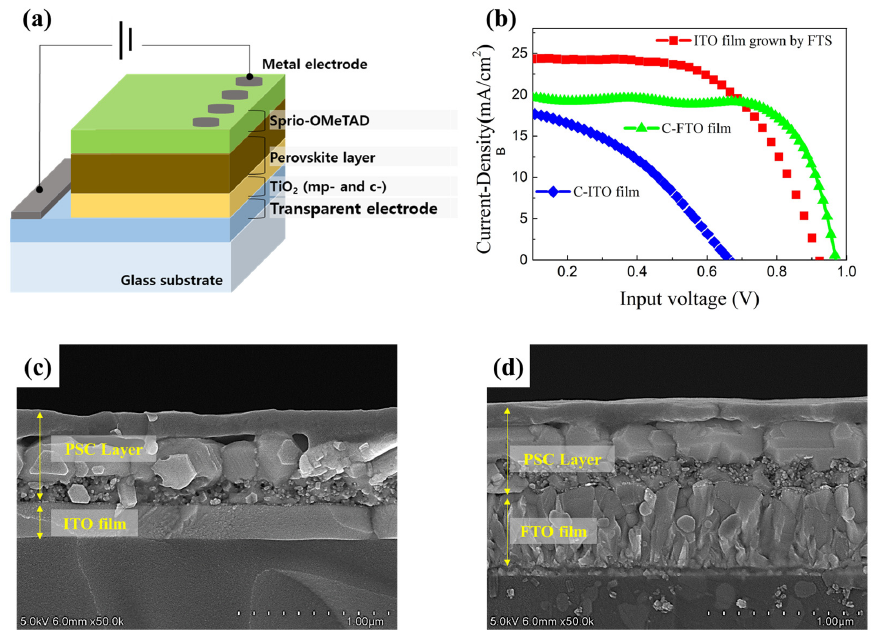
Figure 6. ( a ) structure of a perovskite solar cell consisting of a transparent conductive oxide (TCO), TiO2 layer as electron-transport layer (ETL), light-absorbing perovskite materials, spiro-OMeTAD as hole-transport layer (HTL), and Au metal electrode, ( b ) current density of PSCs with various TCOs (Lab-made ITO, commercial FTO (C-FTO), and commercial ITO (C-ITO)), and cross-sectional FE-SEM images of PSCs with ( c ) ITO film and ( d ) FTO film.